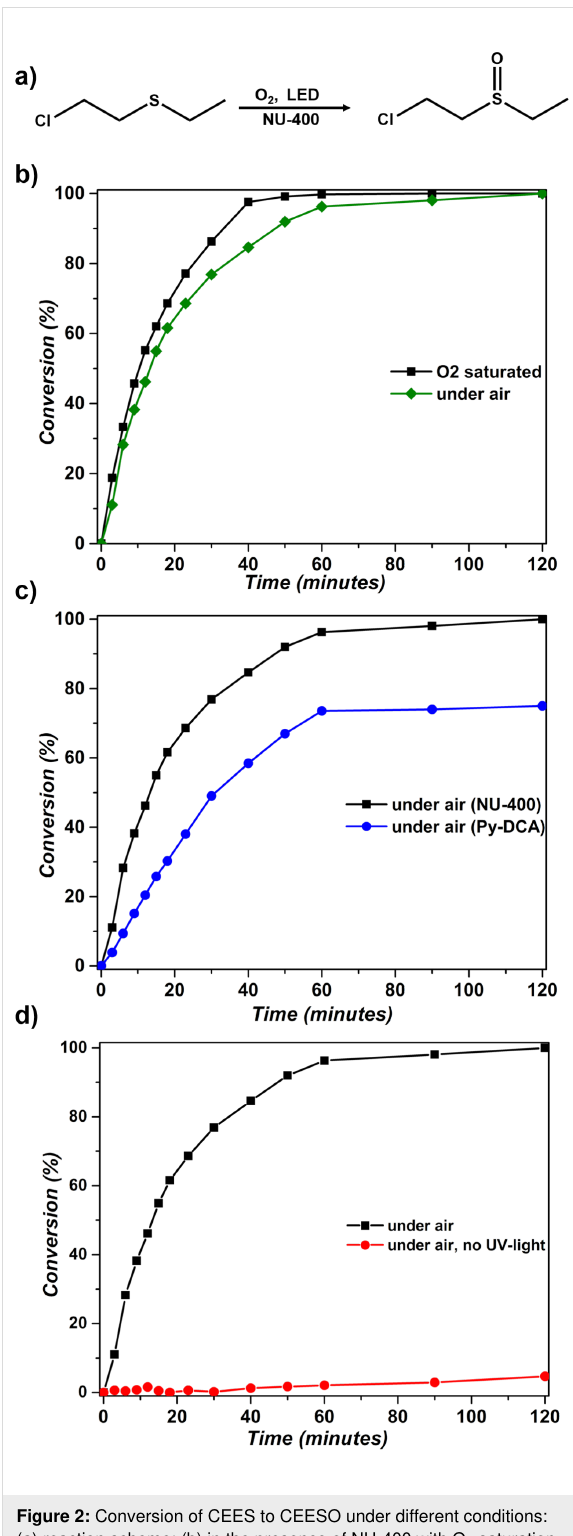
Figure 2: Conversion of CEES to CEESO under different conditions: (a) reaction scheme; (b) in the presence of NU-400 with O 2 saturation and under air; (c) in the presence of Py-DCA with O 2 saturation and under air, and (d) in the presence or absence of UV-light, under air. One mol % (based on Py-DCA) catalyst loading was used for all reac- tions.